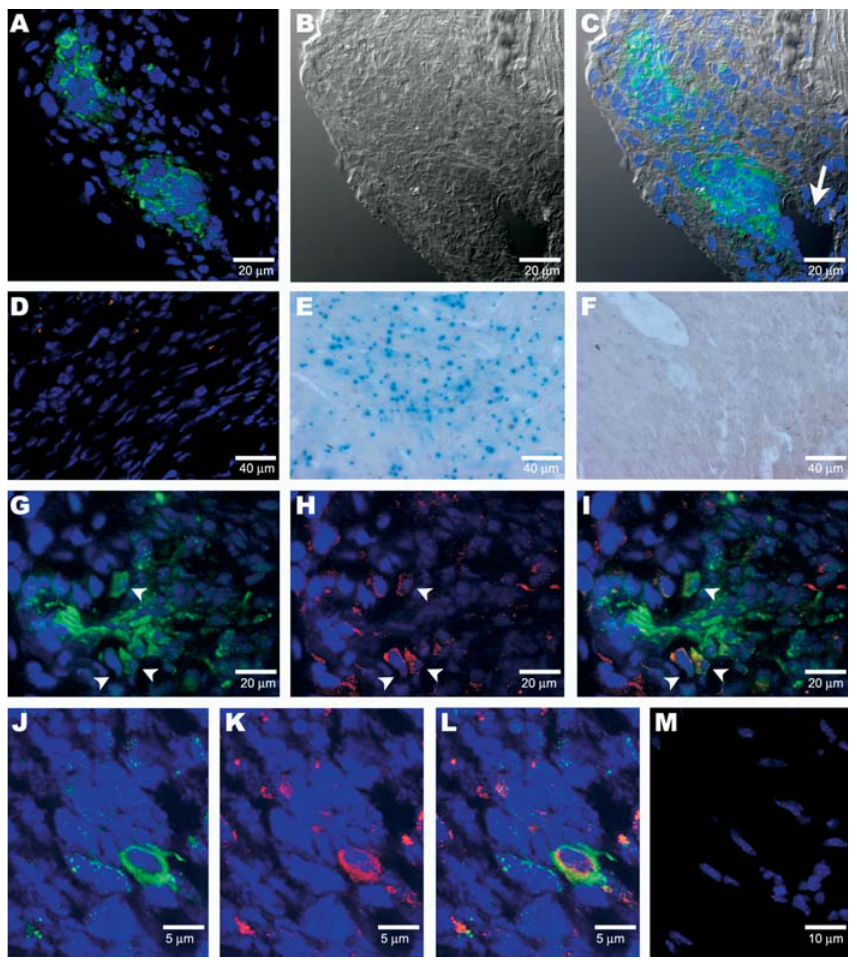
Figure 8. Cre Expressor/Beta-Galactosidase Reporter Myocardial Infarction Studies (A) Nests of Cre þ cells (green) are detected 1 wk after tail-vein injection into an acute infarct model. (B) Nomarski image of (A). (C) Merged image of (A) and (B). The clusters are located near a blood vessel (arrow). (D) Infarcted tissue in a control MI model (infarction surgery but no donor-cell injection) showing a lack of staining for Cre (no green) and GATA-4 (no red). (E) Control X-gal staining of ROSA mouse heart. (F) In a sequential series of tissue sections, odd-numbered sections were immunostained for Cre, yielding the results seen in (A). These two clusters of cells were seen on five sections (sections 1, 3, 5, 7, and 9). Even-numbered sections (sections 2, 4, 6, and 8) were stained for X-gal. No X- gal þ cells were found. One slide was immunostained, showing the Cre þ cells present. This slide was then stained for X-gal and was found to be X- gal (cid:1) . The lack of X-gal staining of the serial sections indicates that at 1 wk no fusion of donor and host cells has occurred in the infarct. (G) Cluster of Cre þ donor cells detected in infarcted heart tissue of a 1-wk-old acute infarct model. Arrowheads indicate cells that also express GATA-4, as shown in (H). (H) GATA-4 (red) is mostly present in some cells in the margin of the cluster. Arrowheads indicate cells that also express Cre, as shown in (G) (I) Merged image showing co-localization (arrowheads) of Cre (green) with GATA-4 (red) in some cells of the cluster of Cre þ cells. (J–L) Co-staining of donor cells with anti–Cre antibody (green) and MSC 21 (red) is apparent after 7 d in an acute infarct model. (M) There is a lack of staining with MSC 21 (no red) in the infracted tissue of mice that have not received Spoc cell